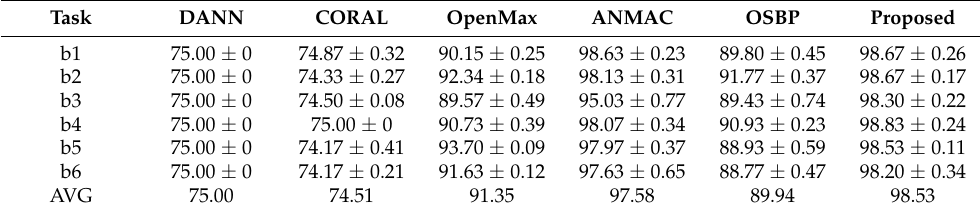
Figure 5. Diagnosis performance comparisons in the lab gearbox dataset. Table 5. Diagnosis results in the CWRU dataset (accuracy (%) ± standard deviation). Table 4. Diagnostic results in the lab gearbox dataset (accuracy (%) ± standard deviation).